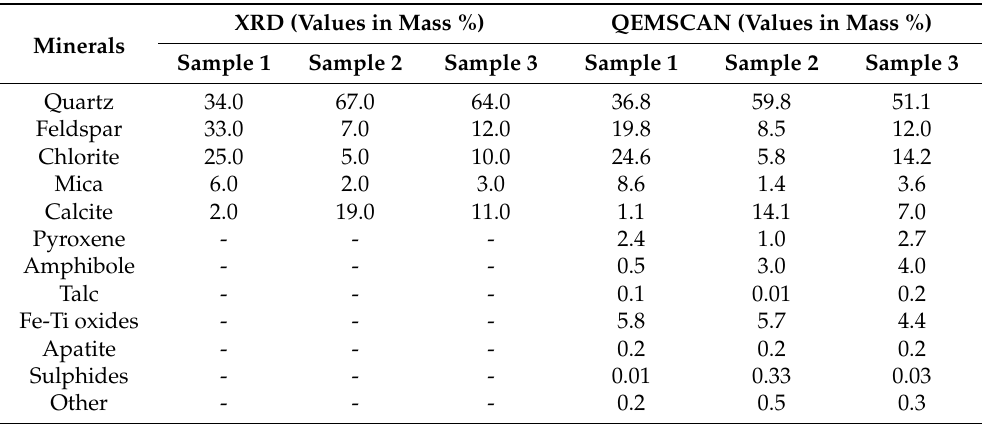
Table 5. XRD and QEMSCAN bulk mineralogy data.